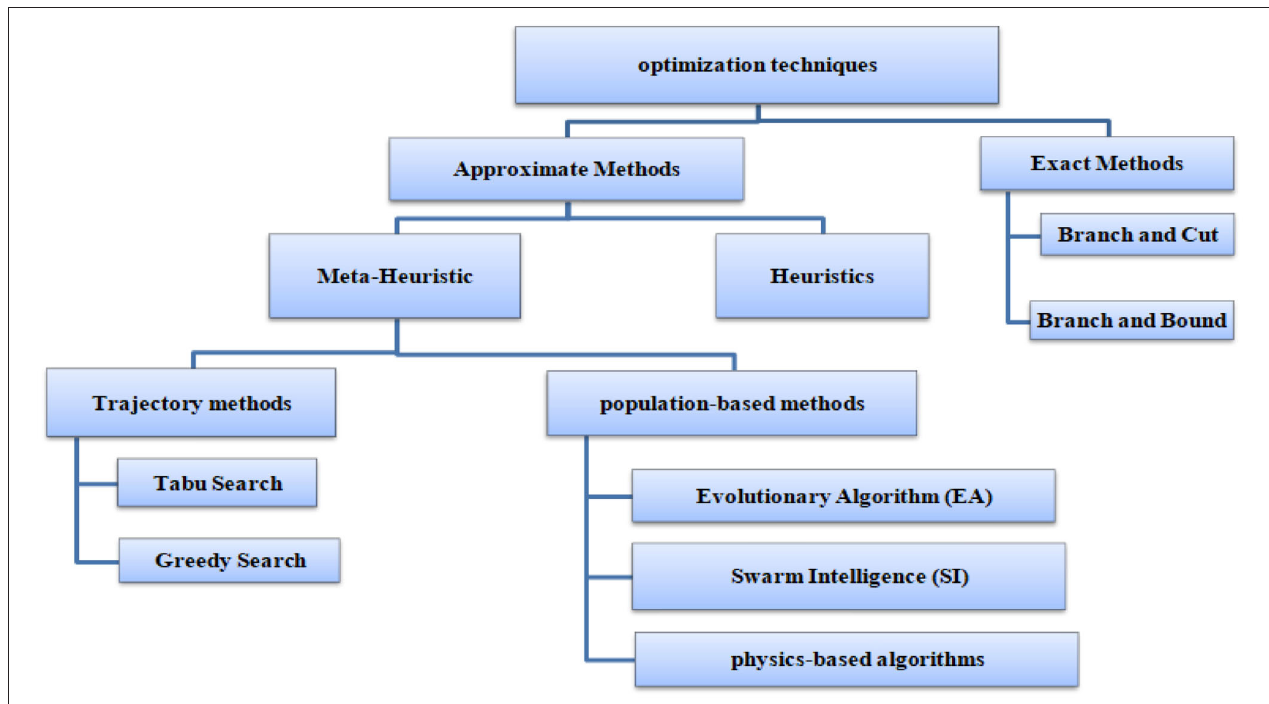
FIGURE 2 | Classification of optimization